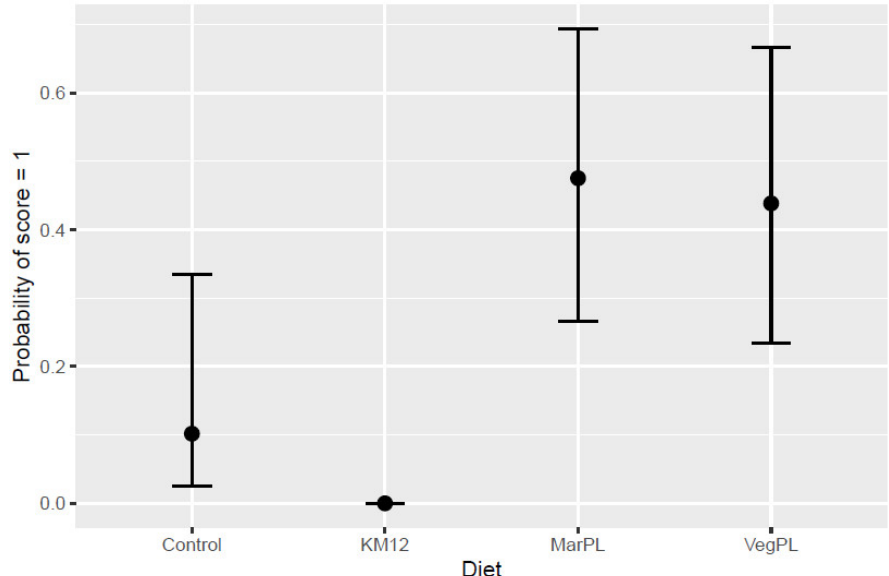
Figure 11. Modelled probability for gill histology score of 1 described as very mild to mild as the most severe observation over a 0 score (no lesions/normal tissue) for ( a ) inflammation of lamella and ( b ) hyperplasia in gills of the fish that were fed diets containing different phospholipid sources after 53 d of feeding in the freshwater pre-transfer phase. Error bars give 95% credible intervals.